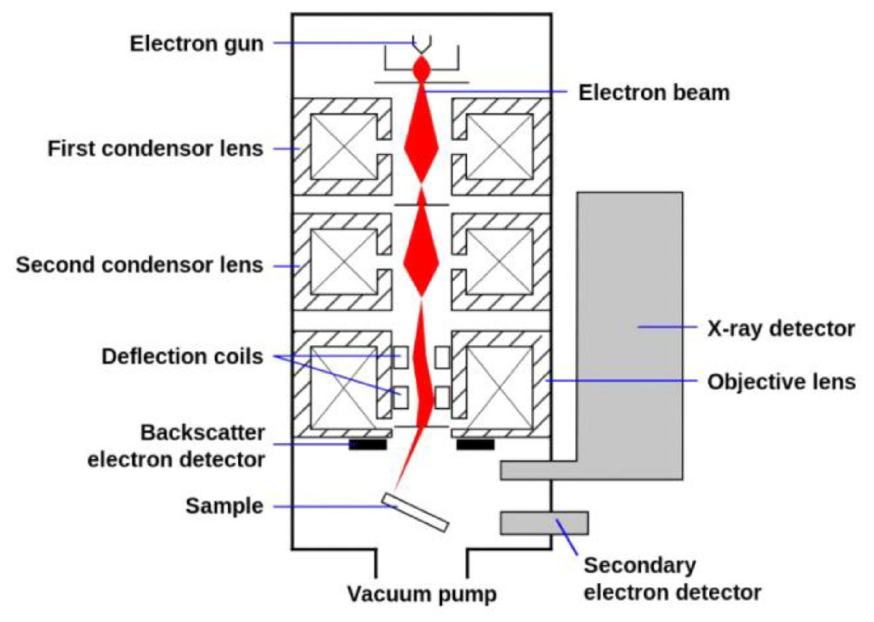
Figure 1. Components of SEM device for surface magnification of membranes [14].